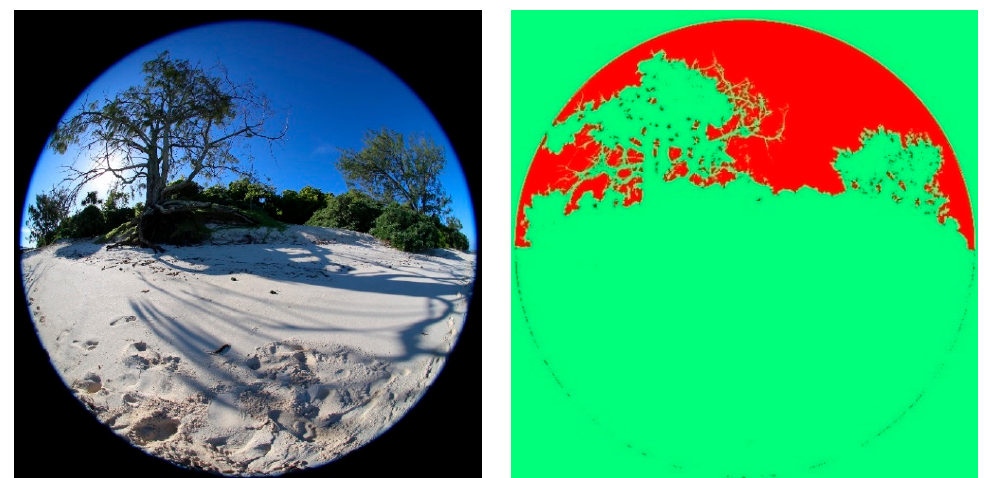
Figure 4. Example of a supervised classification using ImageJ Trainable Weka Segmentation. This figure depicts a classified image ( right ) of the photograph ( left ) taken 29 June 2018 (during the day-time) at sampling site 46 Heron Island, where the sky is displayed in red and everything else (i.e., vegetation and sand) in green.